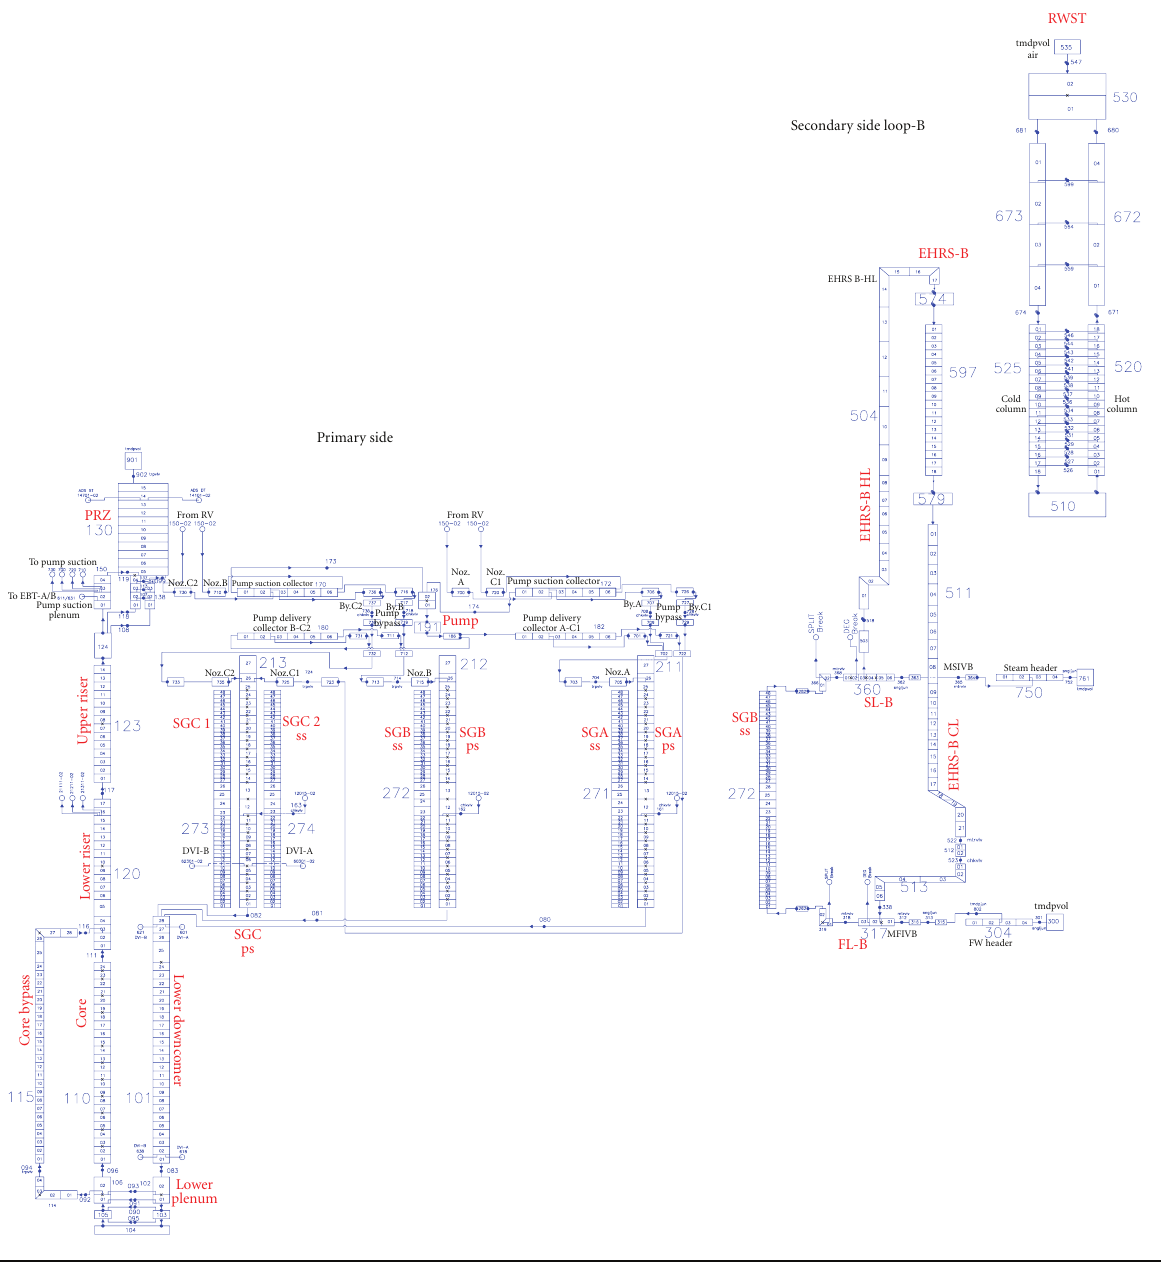
Figure 10: SPES3 nodalization for RELAP5 code: primary side and secondary loop